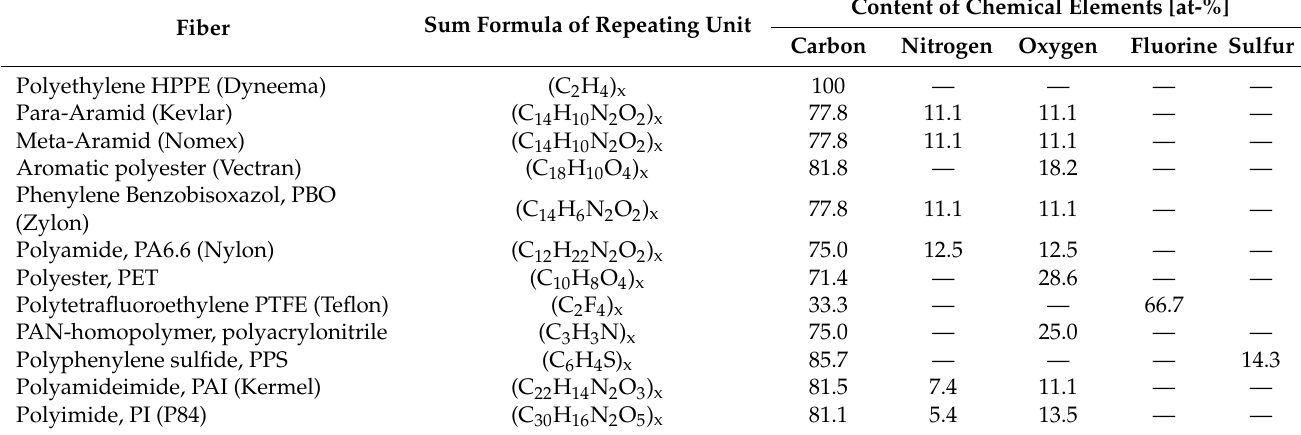
Table 2. Summary of chemical composition of currently investigated high-performance fiber. Listed is the sum formula of the polymer repeating unit and the content containing chemical elements in at-% without the chemical element hydrogen, because hydrogen cannot be detected by EDS